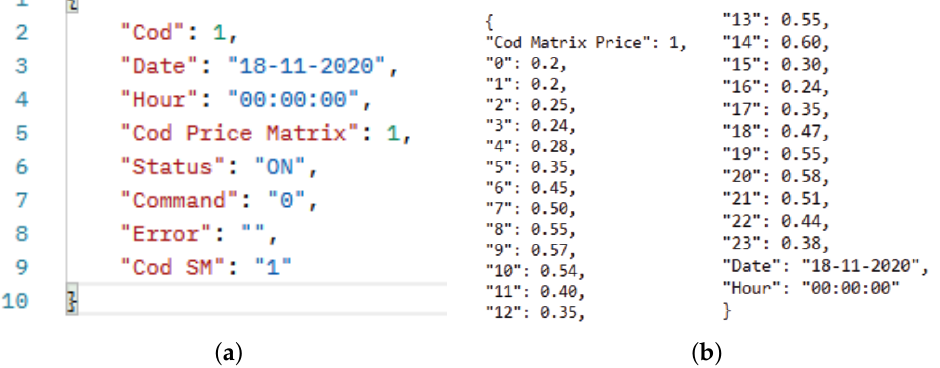
Figure 9. All JSON packages modeled to feed the application database. ( a ) JSON of the right EPC record table. ( b ) JSON of the right price matrix